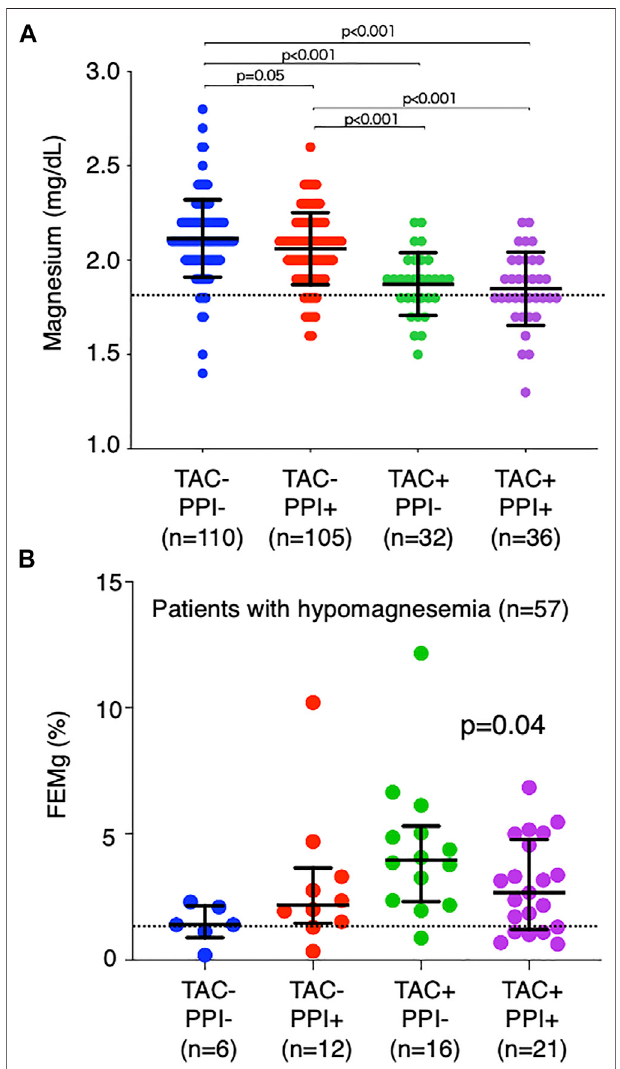
FIGURE 1 | Comparison of magnesium level and fraction excretion of magnesium by drug. All patients were divided into four groups according to TAC and PPIuse. (A) Comparison ofserum Mglevels among thefour groups. Thedottedlineindicatesthenormallimitofthemagnesiumlevel(1.8 mg/ dl). (B) Comparison of FEMg in patients with hypomagnesemia ( n (cid:1) 57). The dotted line indicates the normal limit of FEMg (2.0%). TAC, tacrolimus; PPI, proton pump inhibitor; Mg, magnesium; FEMg, fractional excretion of magnesium.